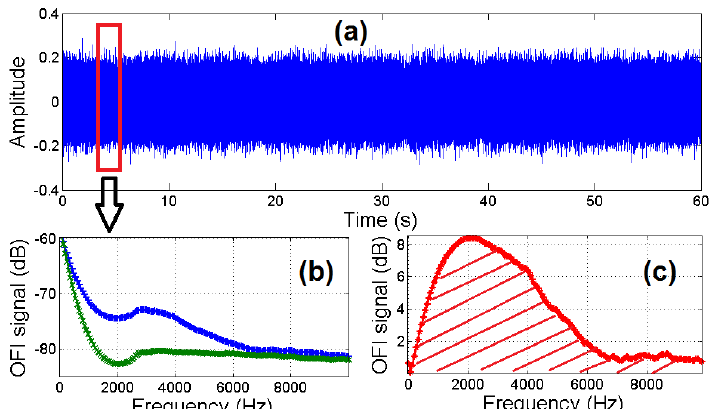
Figure 12. Overview of the signal processing scheme: ( a ) time domain OFI signal while fluid is pumped inside the channel; ( b ) FFT of the OFI signal for circulating fluid (blue) and with the absence of flow (green); ( c ) difference between the OFI signal for flow and the reference.